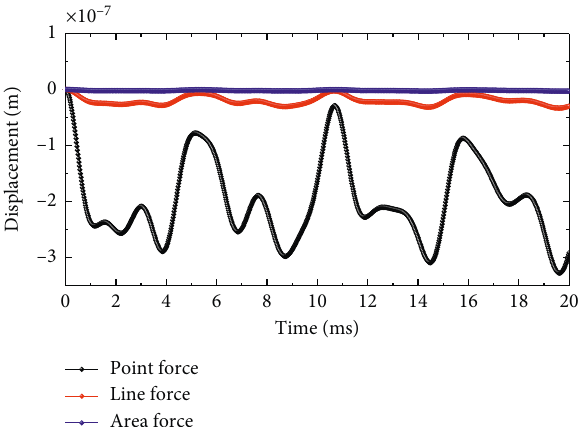
Figure 16: The displacement response of multi-stepped FG-CNTRC plate under different load